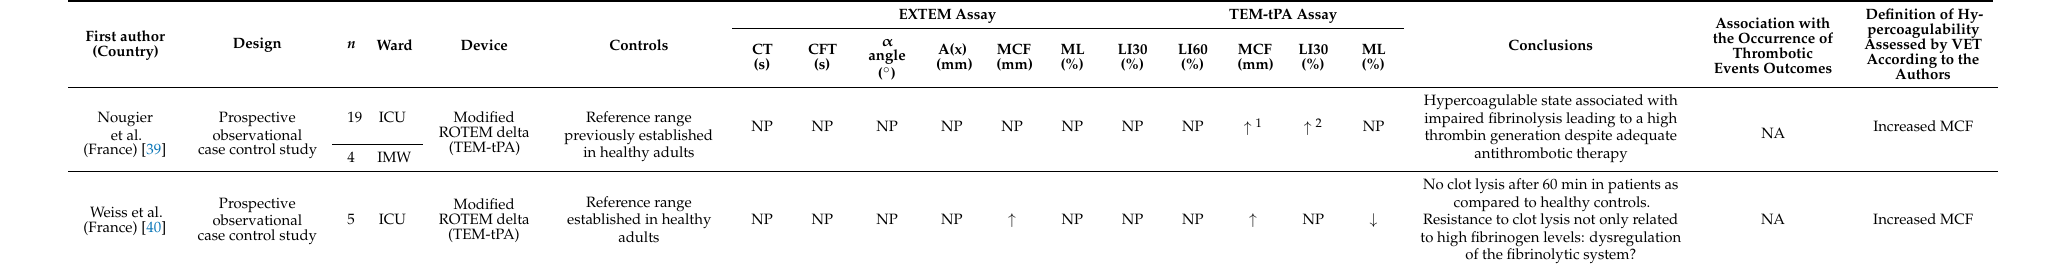
Table 7. Main findings of studies reporting results from the TEM-tPA assay